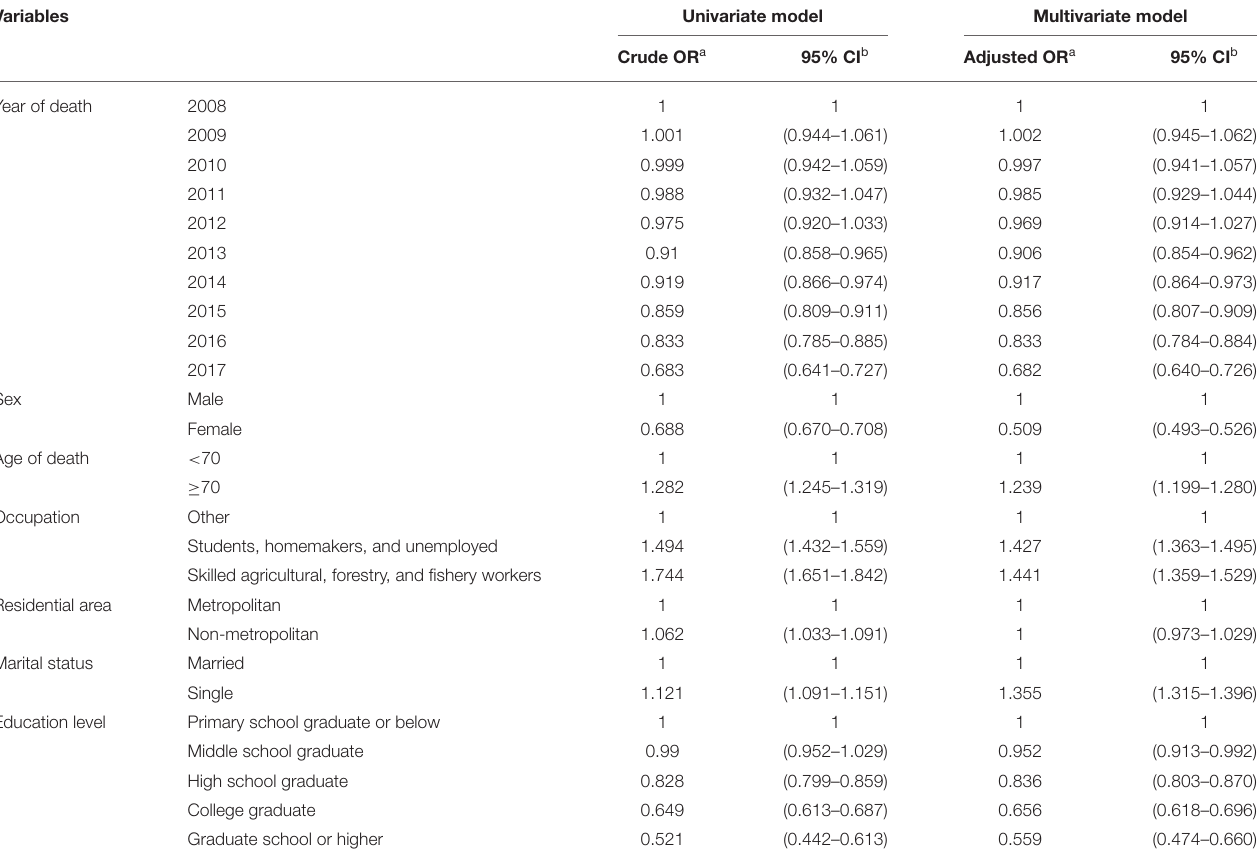
TABLE 2 | Socio-demographic factors contributing to TB-specific deaths using logistic